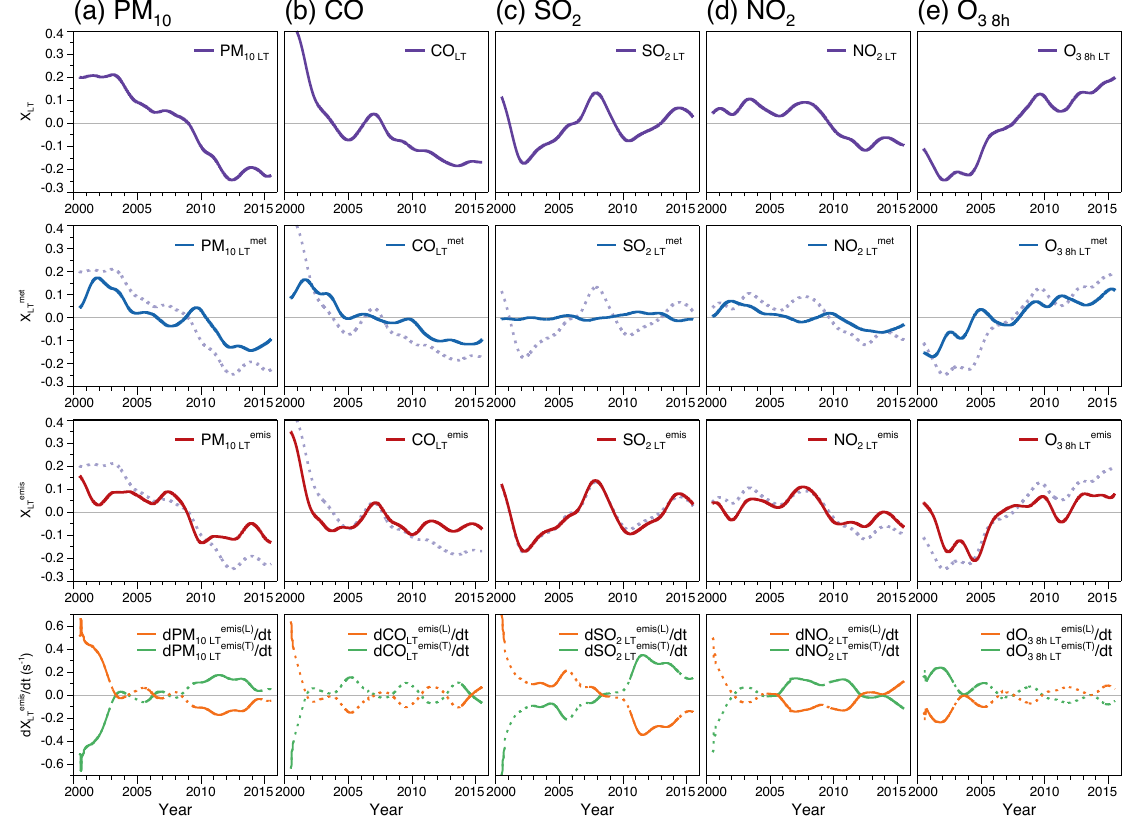
Figure 5. Long-term components that are unadjusted for meteorological variables ( X LT ; violet lines), meteorology-related (cid:0) X met (cid:16) (cid:17) ; redlines X emis and emission-related long-term components, and contributions of local emissions LT (cid:16) ∂ (cid:17) ; green lines X emis ( T ) port of regional emissions to the long-term trends of (a) PM 10 , (b) CO, (c) SO 2 , (d) NO 2 , and (e) O 38h in Seoul. LT ∂t X emis ( L ) X emis ( T ) and ∂ show that the horizontal gradients of X LT ( ∇ X LT ) obtained by linear regression are statistically Solid lines in ∂ LT LT ∂t ∂t significant at the 95% level or higher ( p